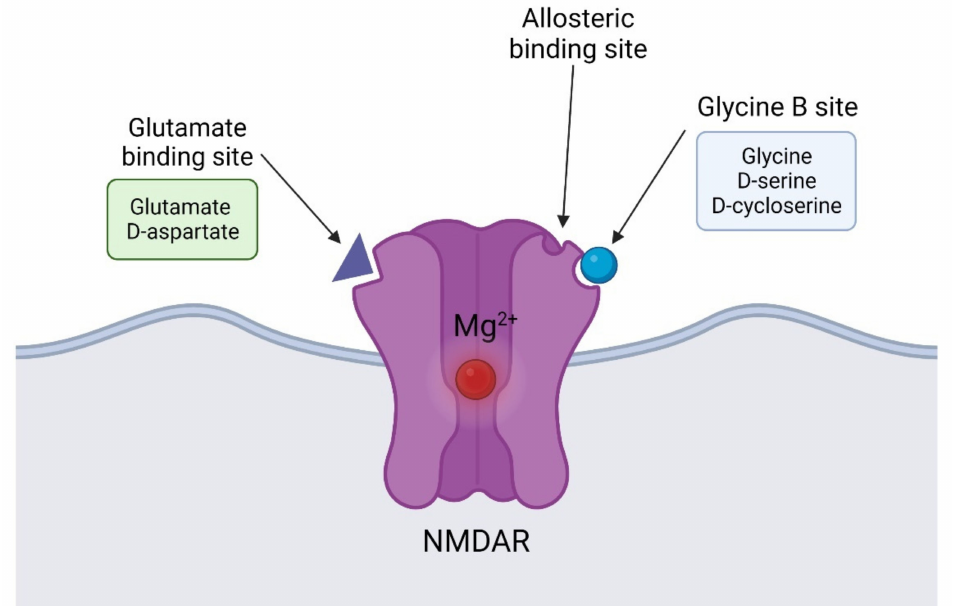
Figure 2. NMDAR structures and binding sites. Whereas glutamate binds to a dedicated glutamate- binding site, the co-agonists D-serine and glycine bind to the so-called “glycine B site”. D-cycloserine acts as a partial agonist at this site. NMDAR activation requires the concomitant binding of glutamate and co-agonists. NMDAR: N-Methyl-D-aspartate receptors; Mg 2+ : magnesium. Created with BioRender.com (accessed on 14 June